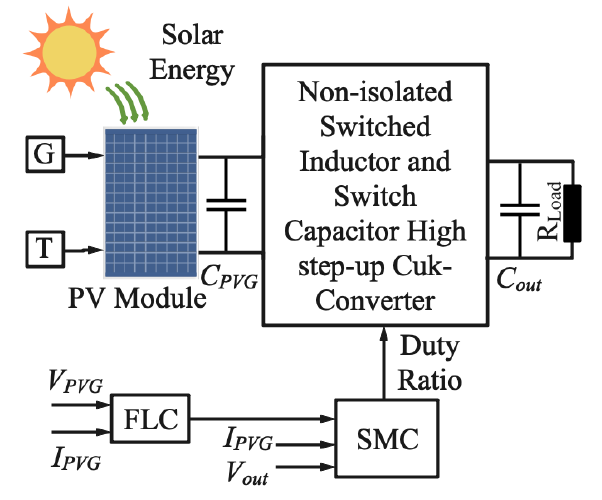
Figure 2. Hybrid FLC-SMC-based MPPT-controlled PV